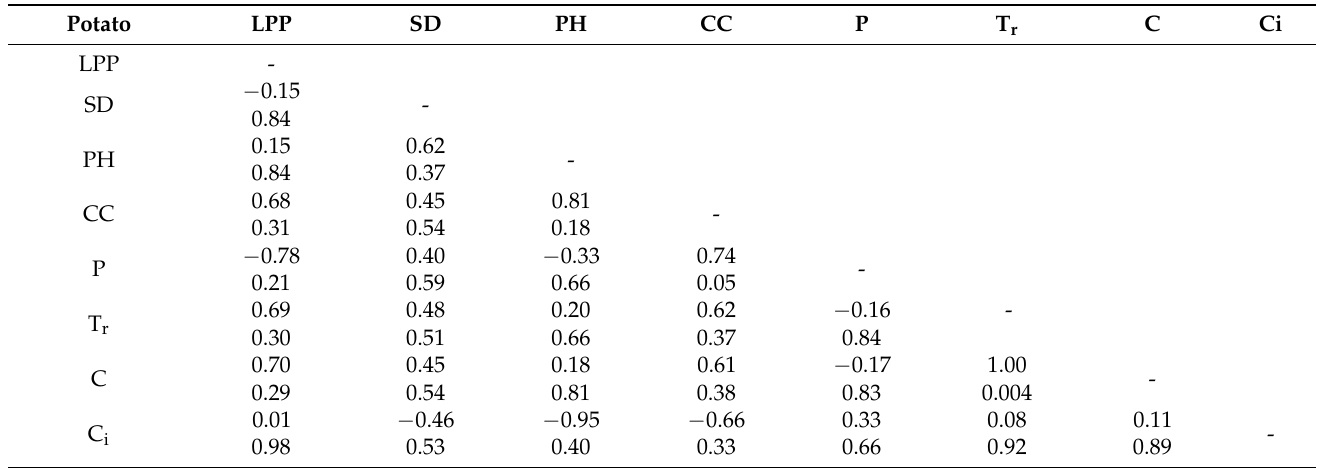
Table 2. Pearson correlation coefficient (upper value) and p -value (lower value) for the potato-infested host plant.